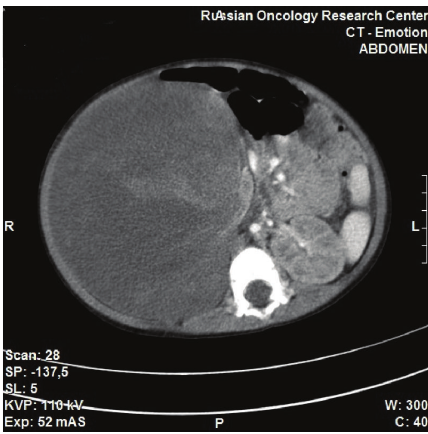
Figure 1: Preoperative abdominal computed tomography: right kidney subtotally replaced by tumor.